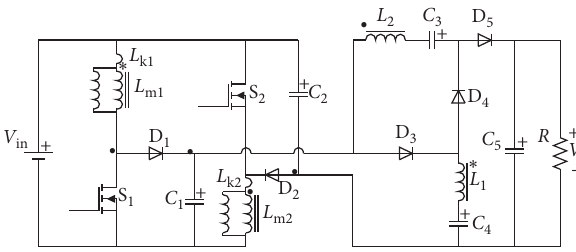
Figure 3: Equivalent circuit diagram.